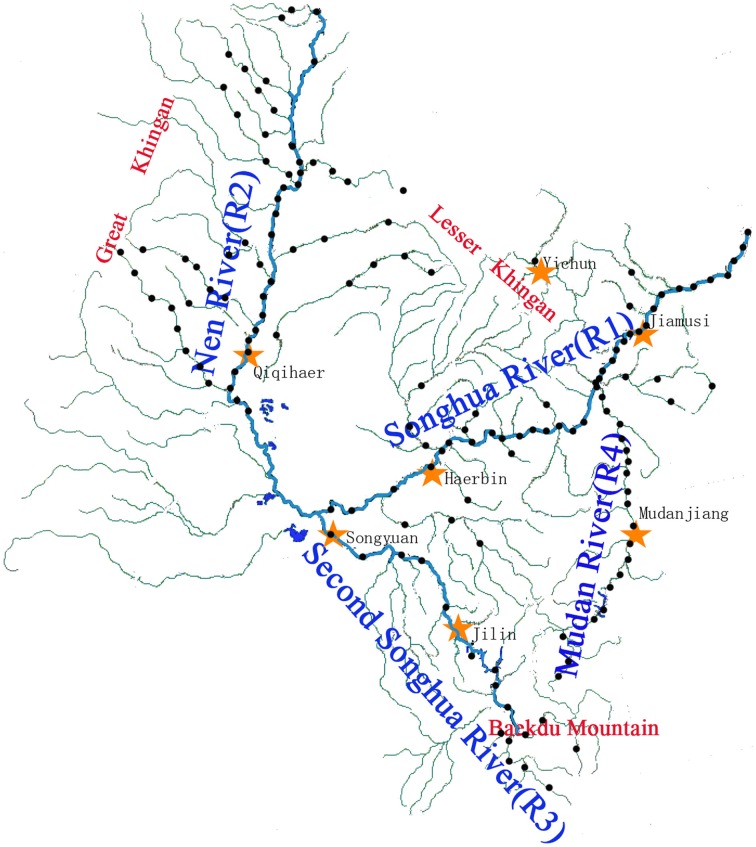
Sampling site distribution map. Two hundred forty-five sampling sites were set, as the sand and gravel in the river bottom zone, and 147 sediment samples were collected in the Songhua River catchment. Sampling was conducted from June to August in 2010. R1, the mainstreams of Songhua River; R2, the Nen River; R3, the second Songhua River; R4, the Mudan River.